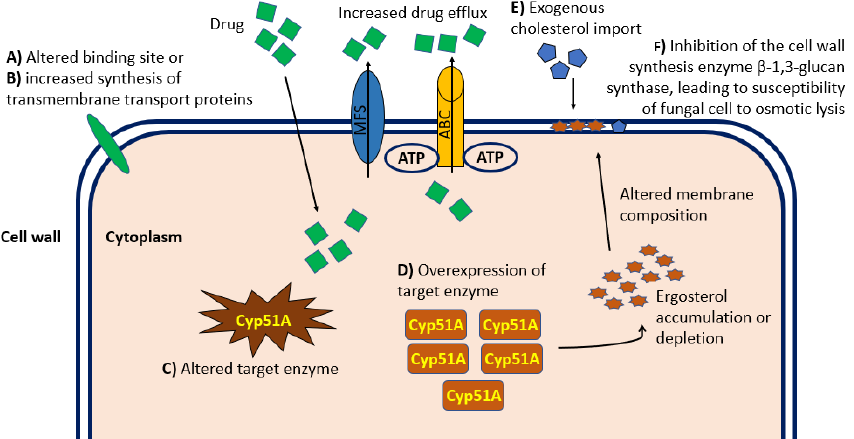
Figure 1. Graphical representation at the cellular level of the principal mechanisms of antifungal drug resistance relevant in the clinical practice. Molecular mechanisms of resistance to antifungal therapy occur mainly through alterations in the cellular binding site ( A ) or increased synthesis of transmembrane transport proteins ( B ), which both lead to reduced intracellular accumulation. In addition, alteration ( C ) or overexpression ( D ) of the enzyme targeted by the drug can cause Ergosterol intracellular accumulation and consequent altered composition and permeability of the cell wall. Import of exogenous cholesterol ( E ) can alter the cell wall composition and permeability resulting in inadequate intracellular drug concentration. Finally, inhibition of the cell wall synthesis enzyme β -1,3-glucan synthase ( F ) can lead to fungal cell susceptibility to osmotic lysis. ABC, ATP-binding cassette transporter family; MFS, major facilitator superfamily of transporters.